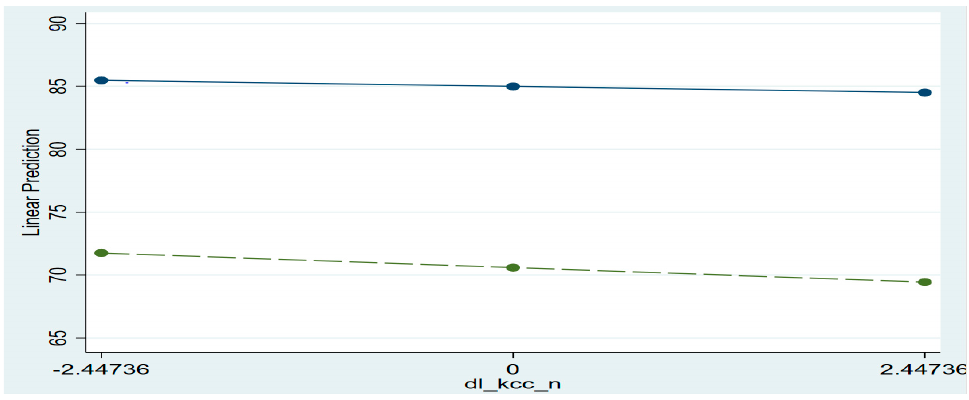
Figure 2. Interaction graph of l_ps_kcc_n. Source: graph created using STATA 16. Note: The solid line of the graph represents the moderating variables’ high − level impact, whereas the long dash line represents the low impact level.